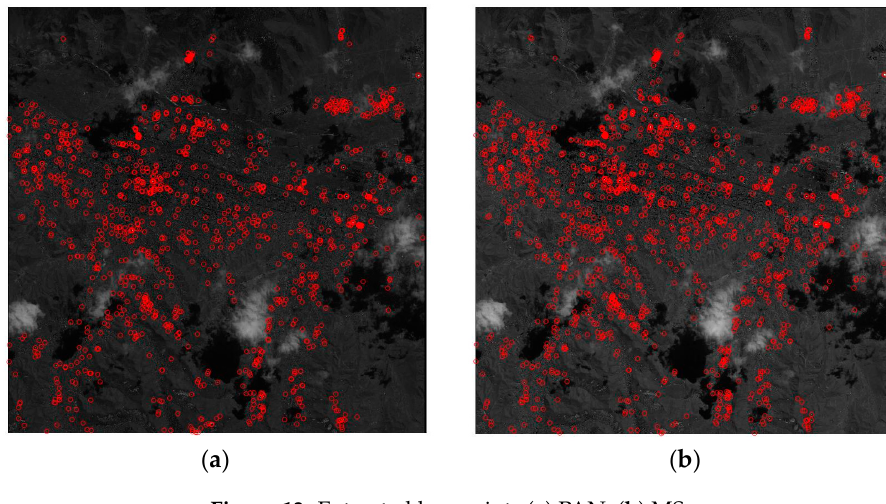
( d ) Figure 12. Examples of pan-sharpened images in false color ( a , c ) before and ( b , d ) after applying image co-registration. 3.6. Comparison to Image Matching-Based Approach We compared the rigorous method to image-matching-based co-registrations. For image- matching, Harris operator and Normalized Cross Correlation (NCC) were used for key points’ extraction and image-matching between PAN and MS, as the extracted key points are presented in Figure 13. The result shows that it is not easy to extract points over mountainous areas such as the upper image region. The threshold for NCC matching was set to 0.8 and a total of 750 points were